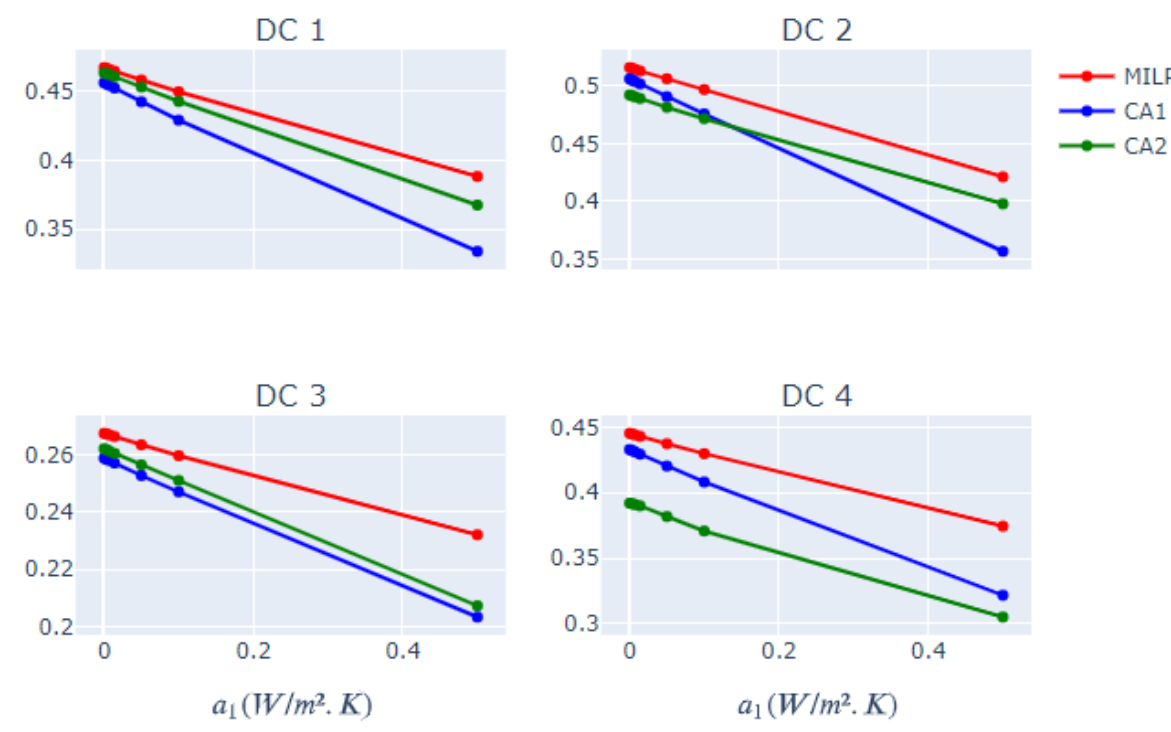
Figure 12. Annual solar fraction as a function of heat losses’ coefficient a 1 (Equation (2)) for the 4 demand curves and 3 control strategies.